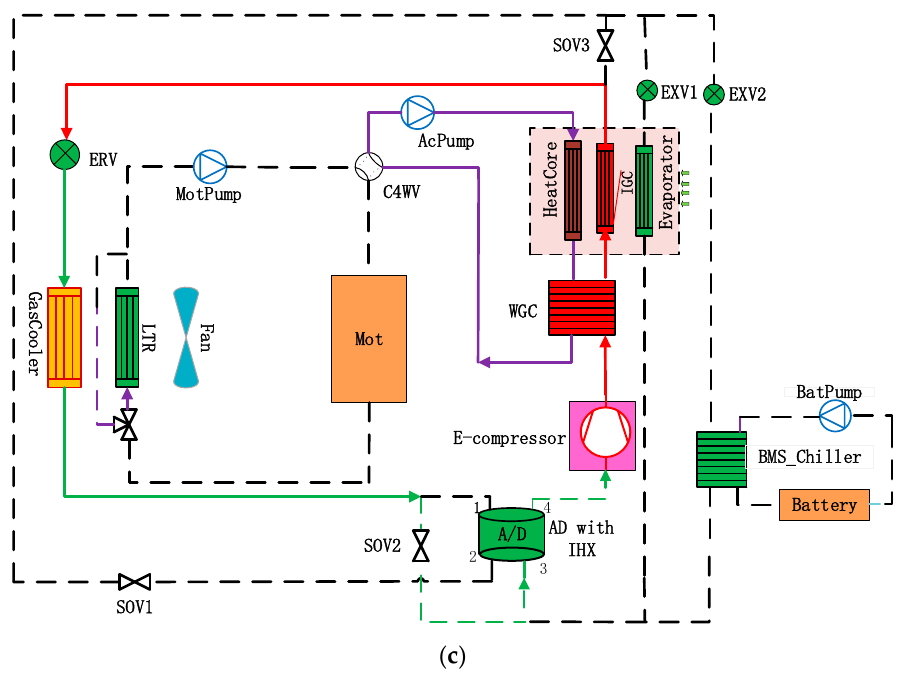
Figure 1. Schematic diagram of the R744 HP system. ( a ) Cooling mode, ( b ) dehumidification mode, and ( c ) heating pump mode.